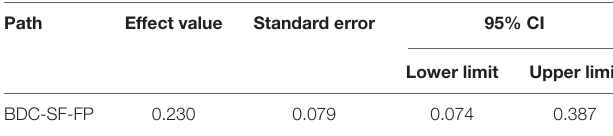
TABLE 6 | Bootstrap analysis of mediating effects.